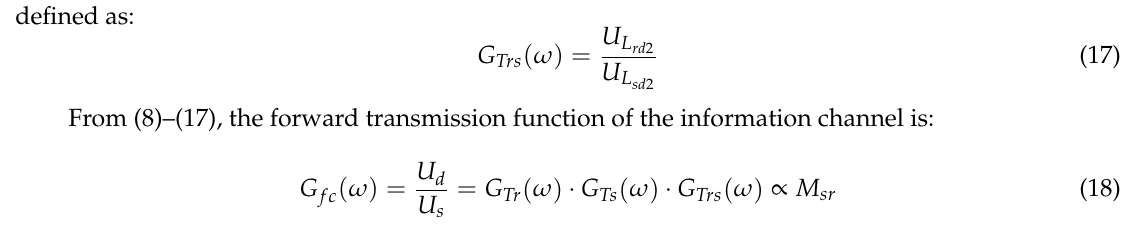
Table 1. Parameters used in the prototype.